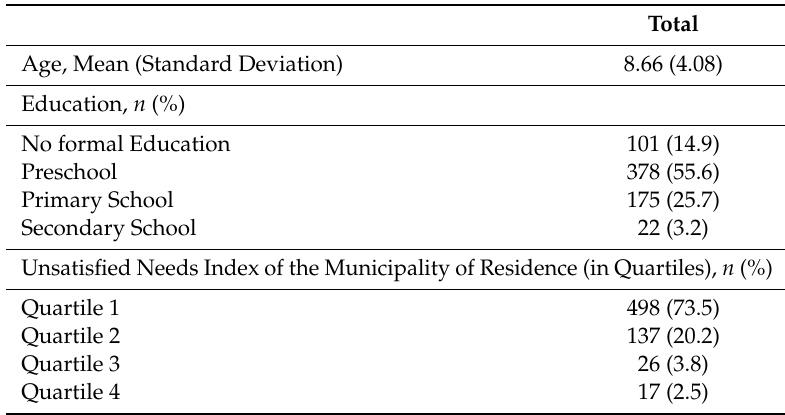
Table 1. Characteristics of the alleged victims ( N = 680).